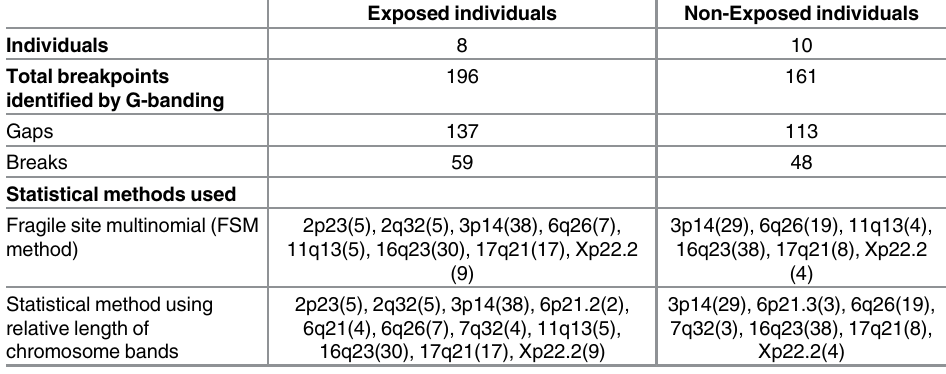
Table 4. Chromosomal damage induced by aphidicolin in exposed and non-exposed individuals to oil six years after oil